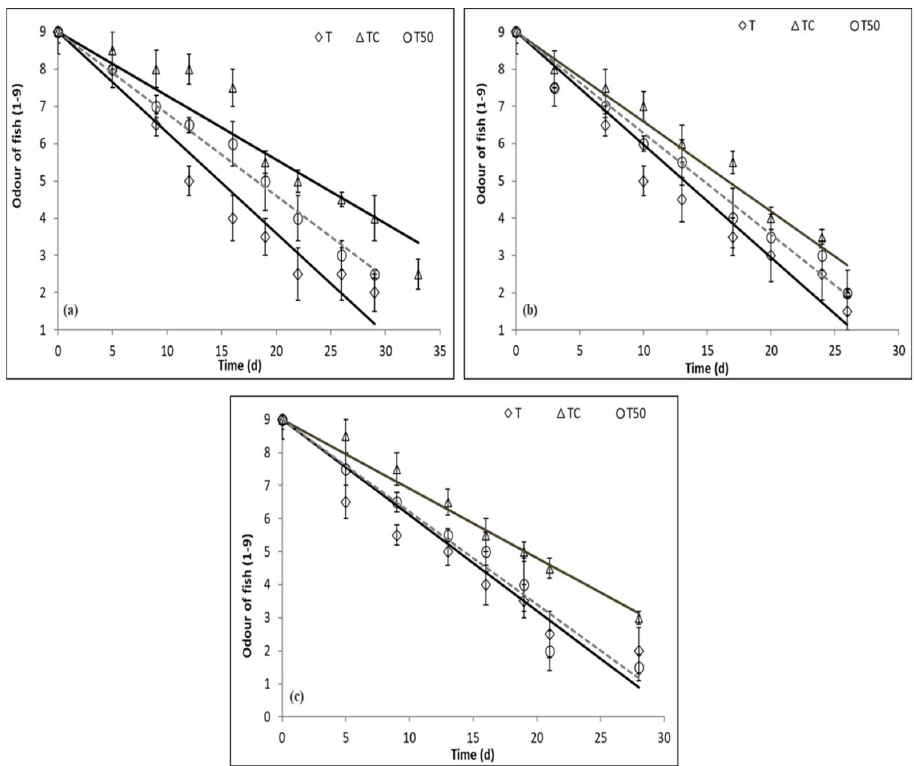
Figure 11. Scores of odor of sea bream samples slaughtered in ( a ) September 2020, ( b ) January 2021, and ( c ) April 2021 during storage at 0 °C ( ◇ T, △ TC, ○ T50).